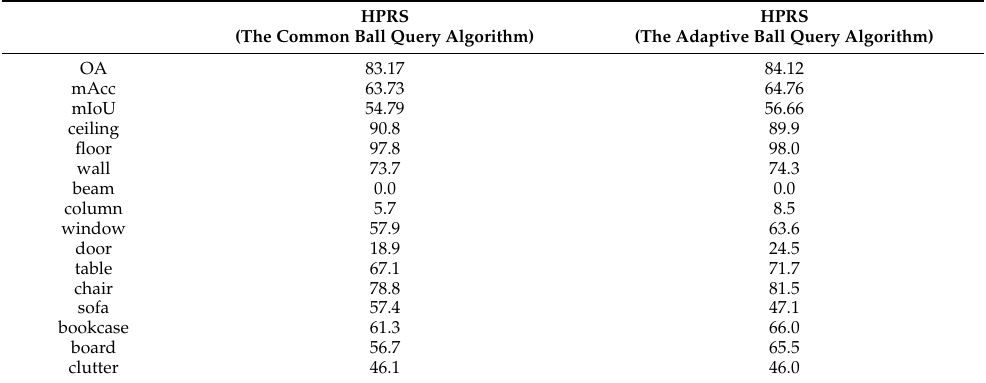
Figure 7. Visualization of segmentation results of the baseline network PointNet, HPRS (K-means) and HPRS on the Area 5. Table 6. Quantitative results of different grouping algorithms within the same HPRS network for the Area 5 (%).